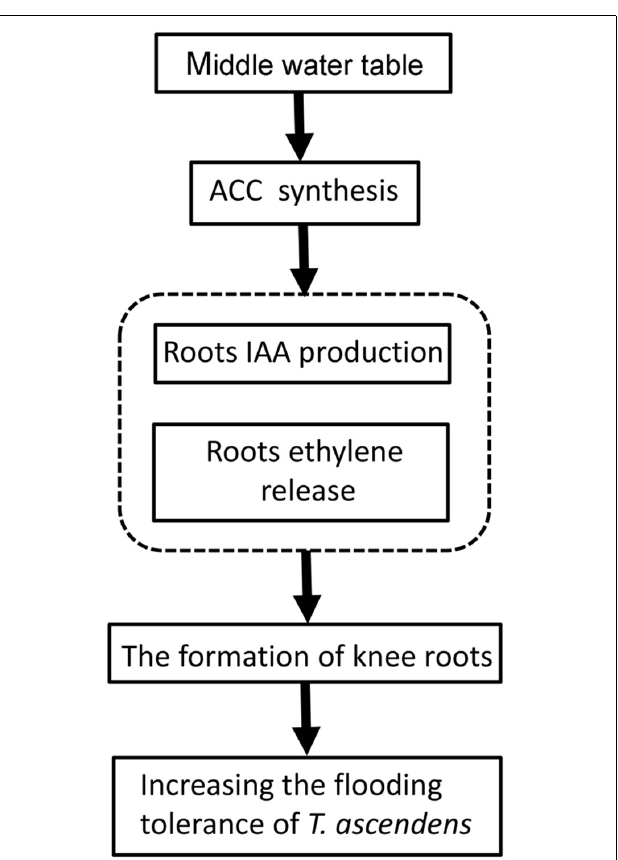
FIGURE 9 | A schematic summary figure showing the adaption mechanism of Taxodium ascendens to flooding stress.